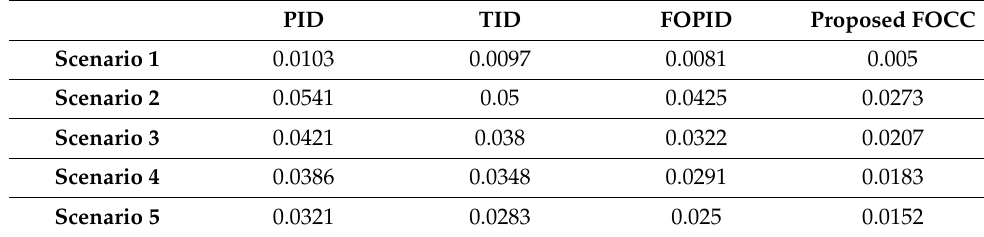
Table 4. Evaluation index of the MG frequency deviation employing different controllers. PID TID FOPID